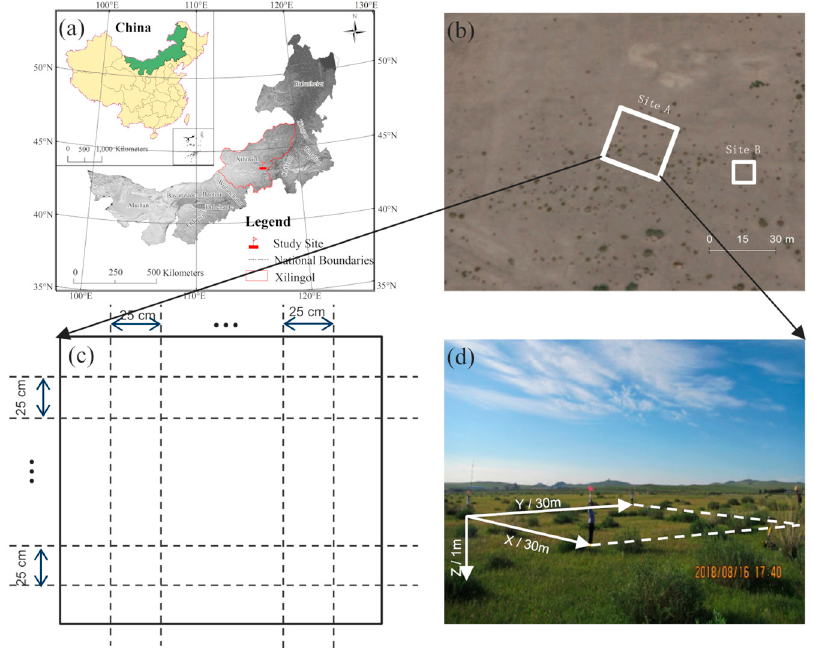
Figure 1. Study area: ( a ) the location of field data collection; ( b ) satellite image of the study area; ( c ) schematic diagram of the ground-penetrating radar (GPR) survey line setting; ( d ) a field photo of Site A.